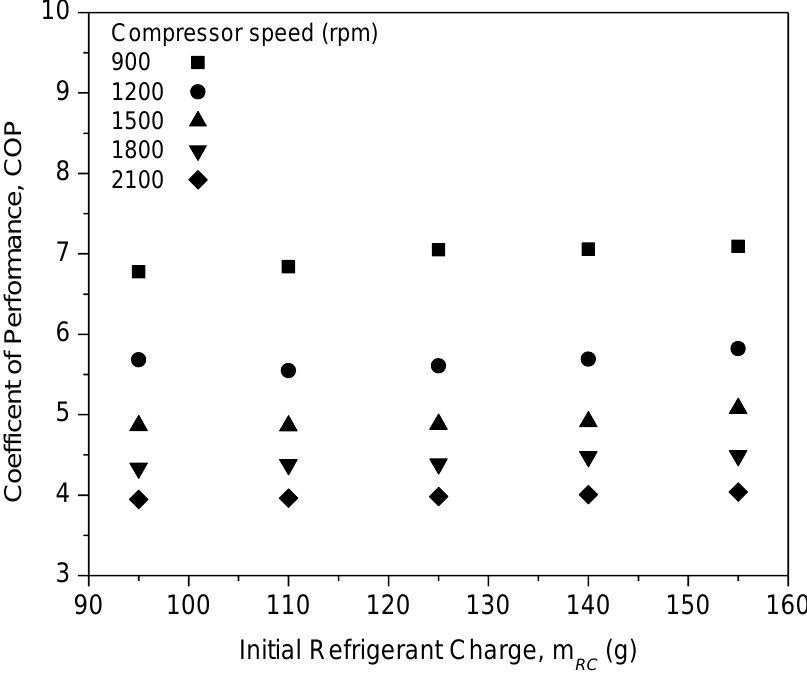
Figure 8. Coefficient of performance (COP) of the pure PAG at various refrigerant charges and compressor speeds.